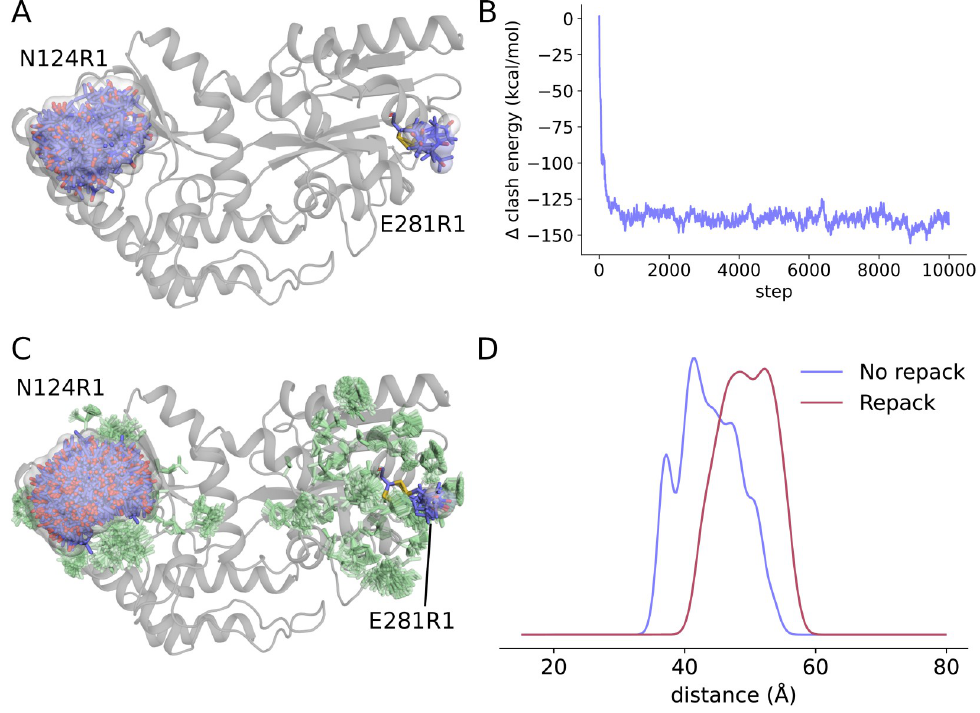
Fig 5. Local side chain repacking for R1 spin label ensembles at sites N124R1 and E281R1 on MBP (PDBID 1OMP). A) Prediction of spin label ensembles without repacking. The protein structure is shown as a gray cartoon. Spin labels are shown as blue sticks. B) Energy trajectory of MCMC repacking, relative to the energy of the starting structure. C) Spin label (blue sticks) and neighboring side chain (green sticks) ensembles obtained from the repacking trajectory. D) Comparison of predicted distance distributions derived from the ensembles of the repacked and the original